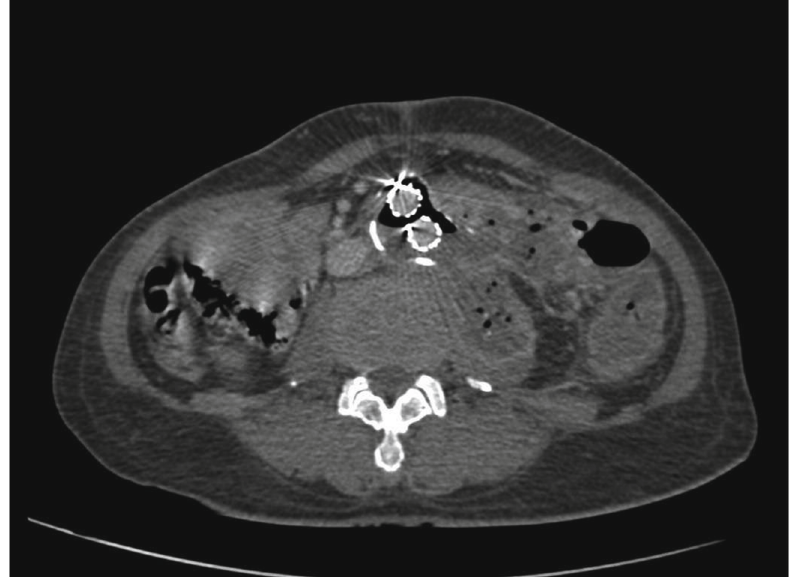
Figure 2: CTA revealed air in the aneurysm sac and left psoas